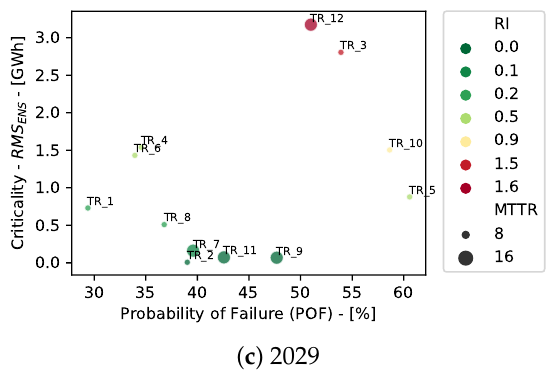
Figure 11. Transformer fleet risk matrix for the assumed periods of planning.